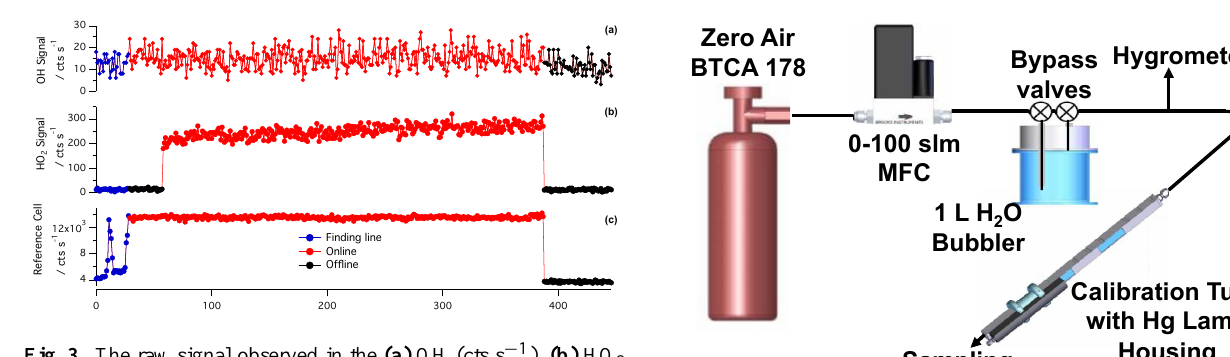
Fig. 3. The raw signal observed in the (a) OH (cts s − 1 ), (b) HO 2 (cts s − 1 ) and (c) reference cell (cts s − 1 ) for a measurement cy- cle during a flight on 8 August 2006. The Q 1 (2) rotational line is scanned over (“finding line”, points 1–25, blue). Online (points ∼ 25–375, red) represents the online measurement period. Offline (points 375–450, black) represents the background signal to be re- moved in the analysis. A 2.2% (1 σ ) variation in reference signal is observed online.